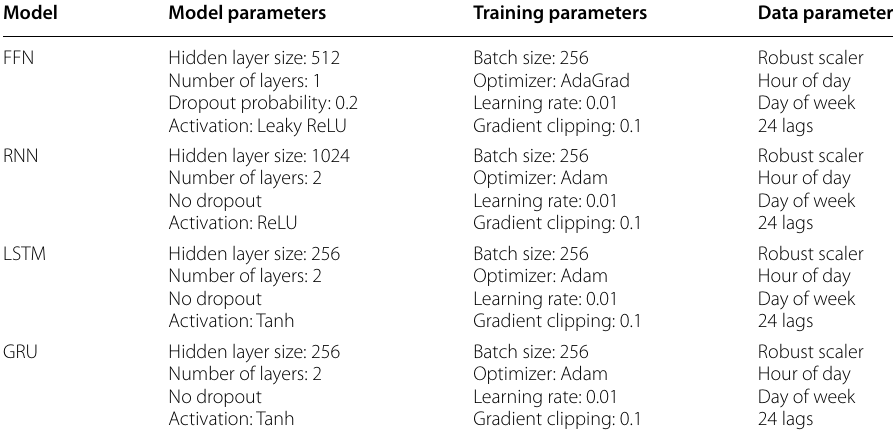
Table 5 Results of the hyperparameter tuning Model Model parameters Training parameters Data parameters